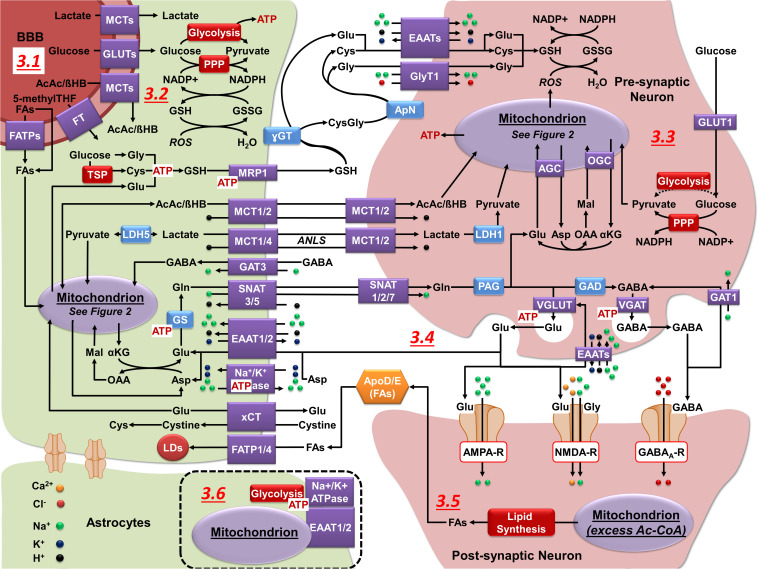
Neuronal-astrocytic metabolic cooperation. (3.1) GLUTs (glucose), MCTs (lactate and ketone bodies), and FATPs (FAs) facilitate the transport of carbon sources across the BBB. 5-methylTHF is the predominant form of folate in the blood and its transport across the BBB is mediated by different folate transporters (FT). (3.2) Astrocytes utilize glucose for the production of ATP (glycolysis), regeneration of NADPH (PPP), and to feed mitochondrial biosynthetic processes. Astrocytes synthesize and export GSH (MRP1), lactate (MCT1/4), ketone bodies (MCT1/2), and glutamine (Gln) (SNAT5) that can be utilized by neurons for energy production and synthesis of neurotransmitters. (3.3) Neurons utilize glucose primarily for the regeneration of NADPH (PPP), with some studies suggesting that glycolysis can be upregulated during energy-demanding conditions. Lactate and ketone bodies are used in ATP production (OXPHOS). Neurons import GSH precursors from astrocytes via EAATs and GlyT1, lactate and ketone bodies via MCT1/2, and Gln through SNAT1/2/7. (3.4) Upon their release into the synaptic cleft Glu and GABA neurotransmitters can be uptaken into neurons via EAATs and the GABA transporter 1 (GAT1). However, astrocytes have a higher capacity to uptake and metabolize these neuroransmitters. In astrocytes, GABA is metabolized in the mitochondria (see Figure 2.4). Glu is taken in by astrocytes (EAAT1/2), converted to Gln (GS), and exported for neuronal uptake. In the neurons, Gln is converted to Glu via PAG and then Glu can be converted to GABA via GAD. Neurotransmitters are subsequently loaded into vesicles via vesicular transporters (VGLUT or VGAT), which do not require ATP per se, but their activity is coupled to that of the vacuolar H+ ATPase. The Na+/K+ ATPase maintains the electrochemical gradient required to sustain neuronal excitability (not shown) and in astrocytes it is essential to drive neurotransmitter uptake. (3.5) During periods of excess Ac-CoA, lipid synthesis is initiated. Lipids are then transported to astrocytes in an apolipoprotein D/E dependent manner, taken in by FATP1/4, and transferred into LDs. (3.6) In astrocytes, mitochondria co-localize on the plasma membrane with EAAT1/2, Na+/K+ ATPases, and glycolytic enzymes.